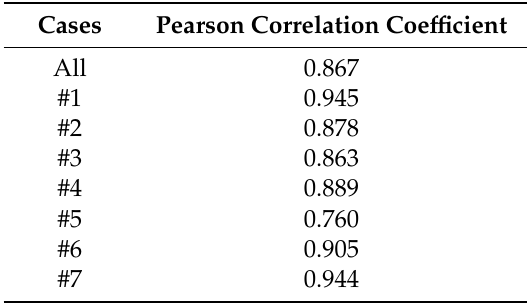
Figure 4. HOE / ERL% ratio vs. active systems. Figure 4. HOE/ERL% ratio vs. active systems. Table 11. Correlation between HOE / ERL% and the number of active Table 11. Correlation between HOE/ERL% and the number of active systems.